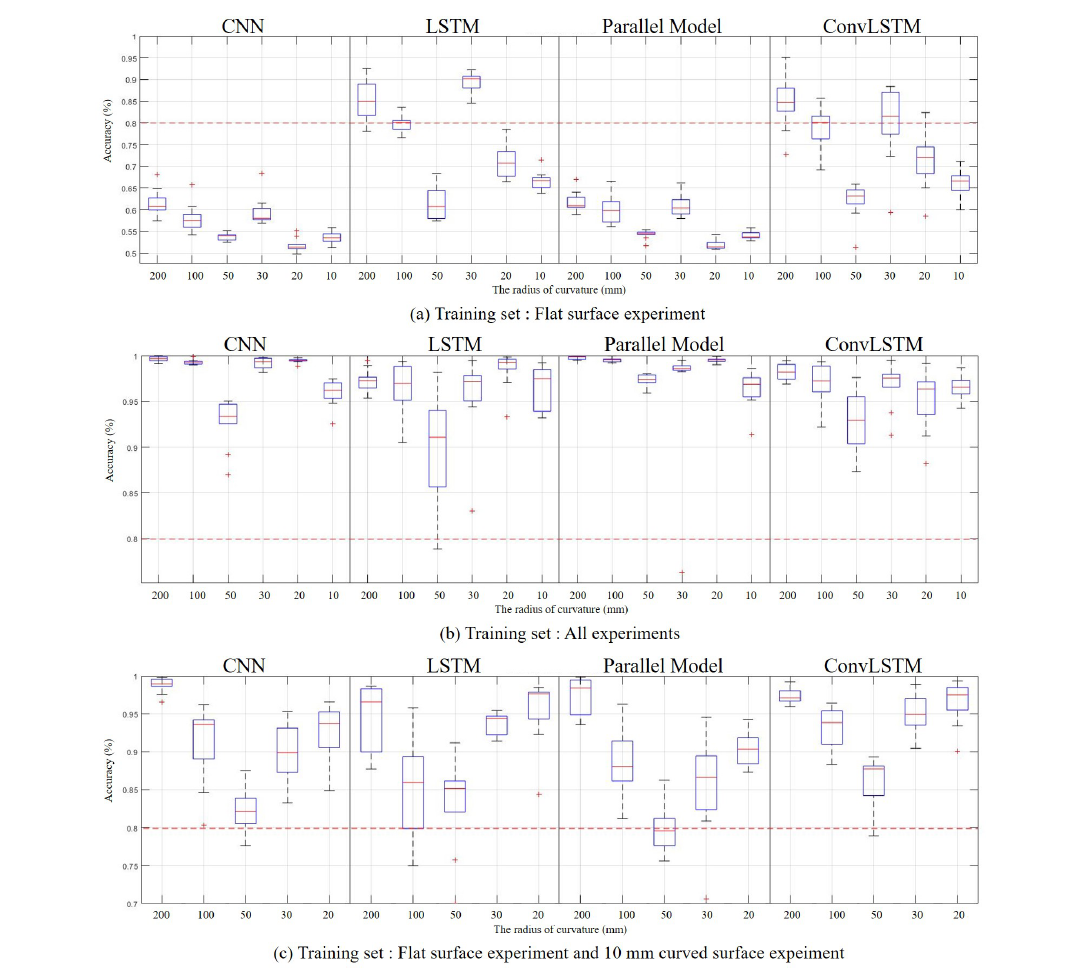
Figure 11. Result: Curves surface